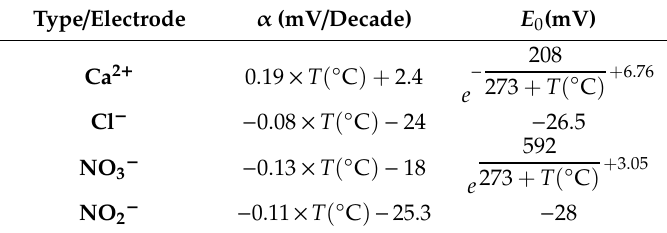
Table 4. Modified Nernst Parameters for selective